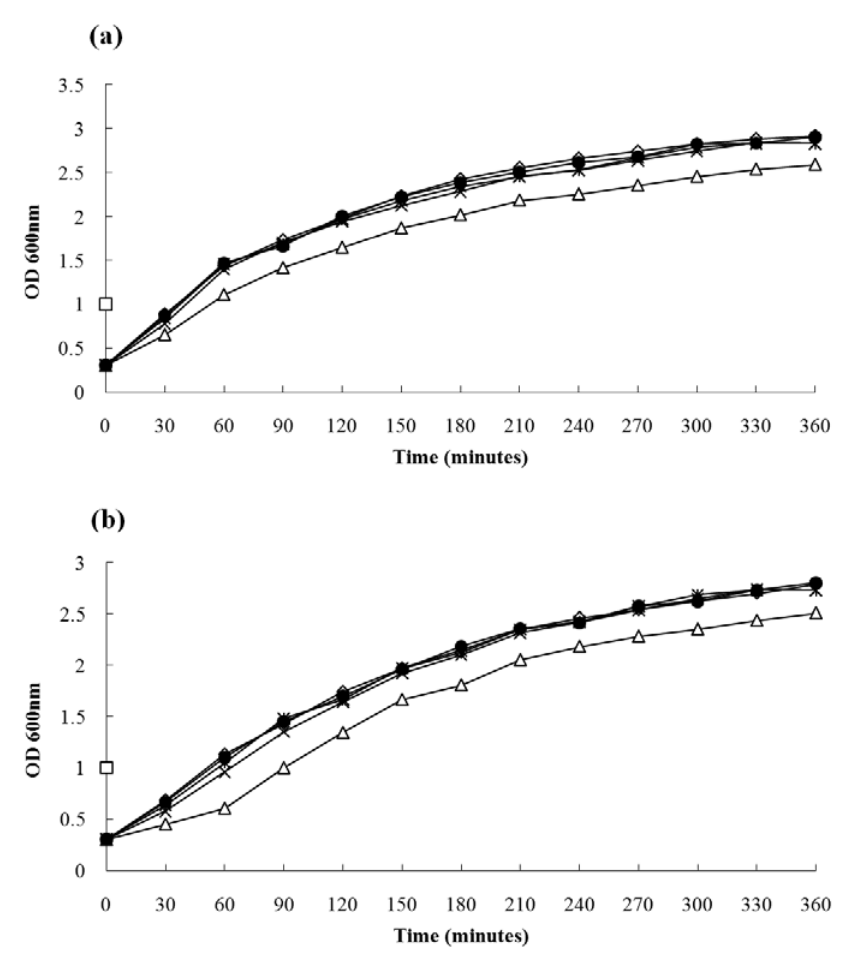
, and △ — Strain ATCC 29213 and *